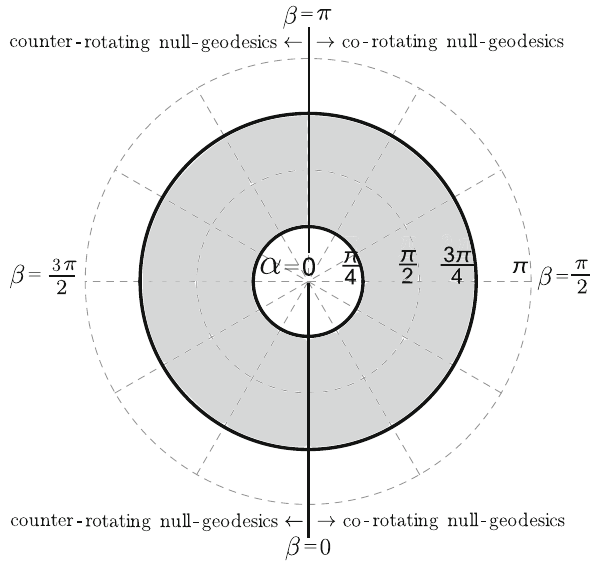
Fig. 3 An example of an escape cone, for a non-rotating configura- tion with R / M = 2 . 4, located at the position of the stable circular photon orbit. The figure emphasizes the positions of the angle α = { 0 ,π/ 4 ,π/ 2 , 3 π/ 4 ,π } , which has the character of a radial coordinate inaclassicalpolargraphandtheangle β = { 0 ,π/ 2 ,π, 3 π/ 2 } ,whichhas the character of an angular coordinate in a classical polar graph. The figure is also divided into “left” and “right” parts, for null geodesics which are co-rotating ( β ∈ ( 0 ,π) ) and counter-rotating ( β ∈ (π, 2 π)